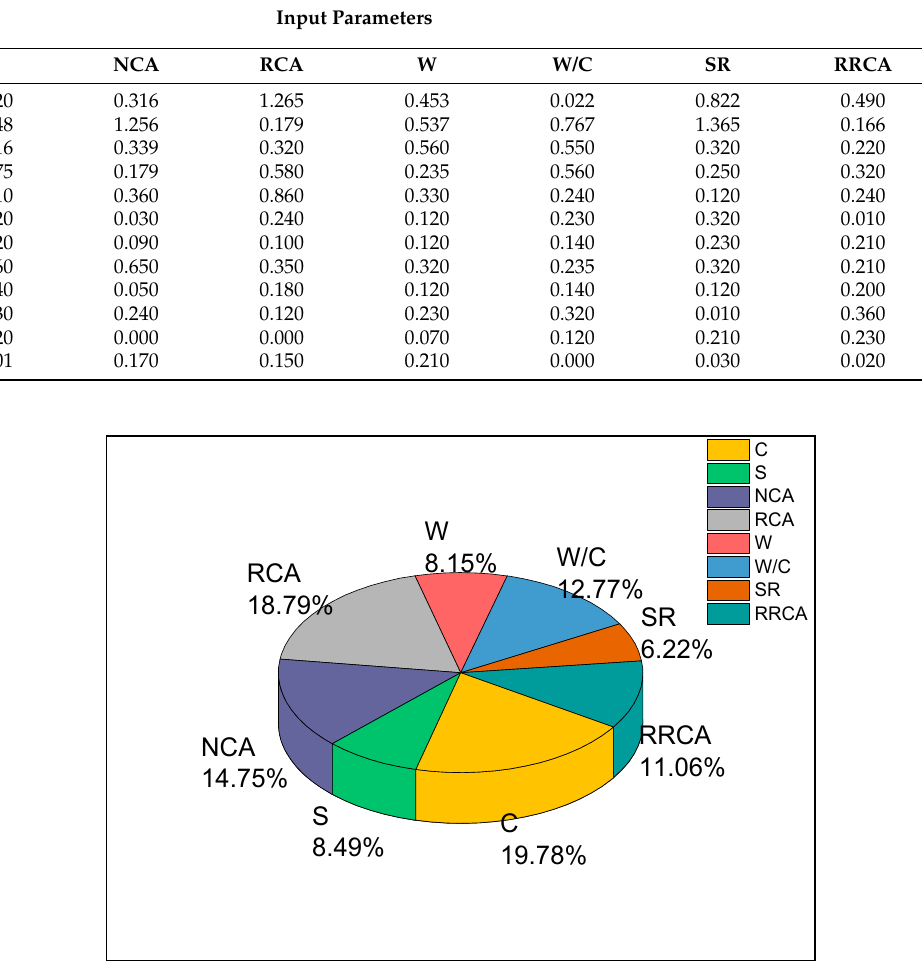
Figure 28. Single parameter effect on the prediction of RAC compressive strength.